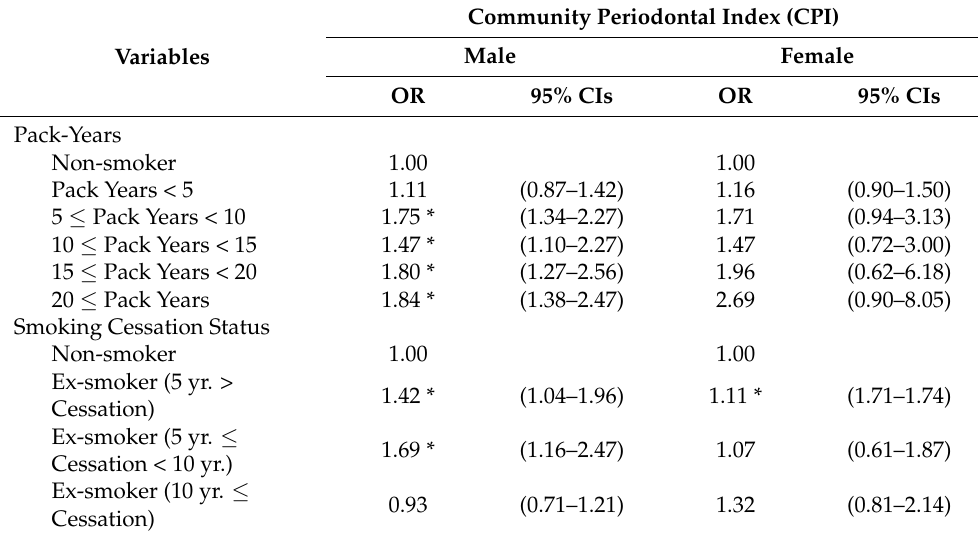
Table 4. Results of subgroup analysis stratified by pack years and smoking